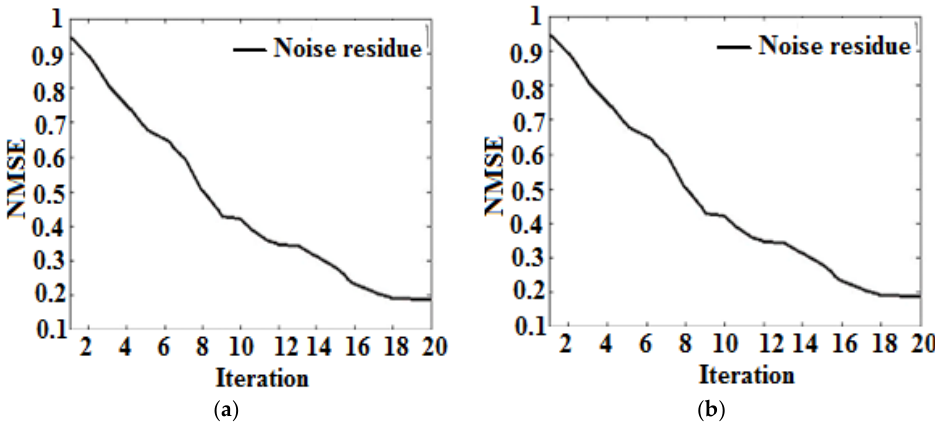
Figure 5. Number of iterations versus normalized mean square error. ( a ) Proposed method; ( b ) Existing method.